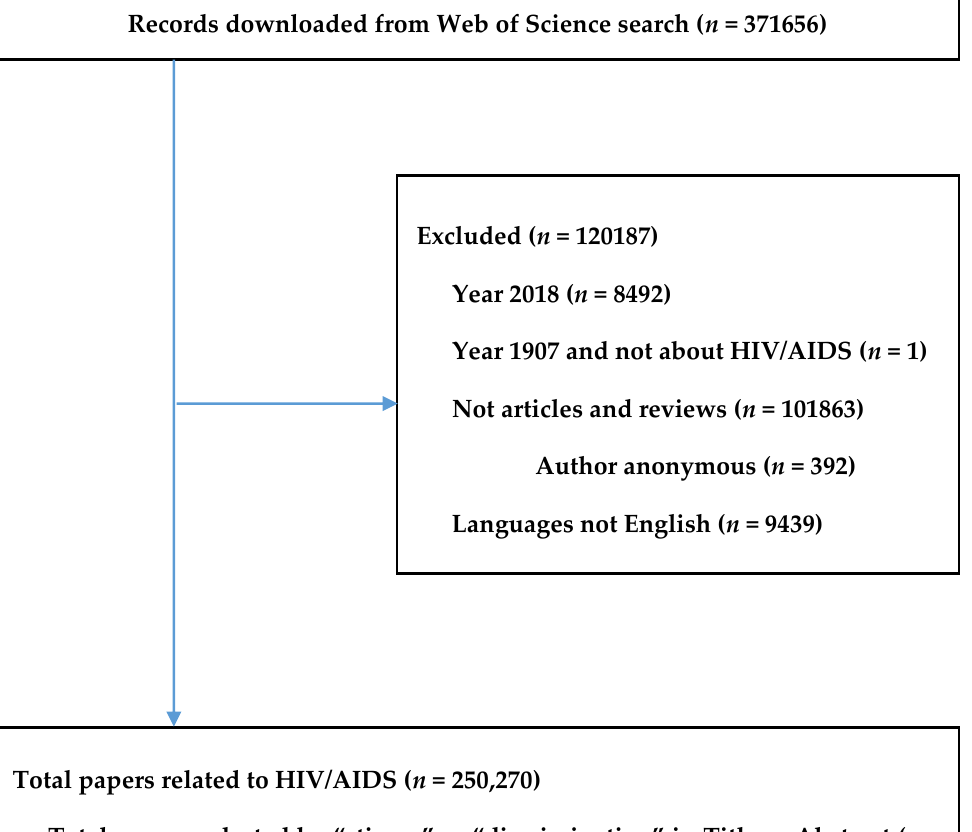
Figure 1. Selection of papers.